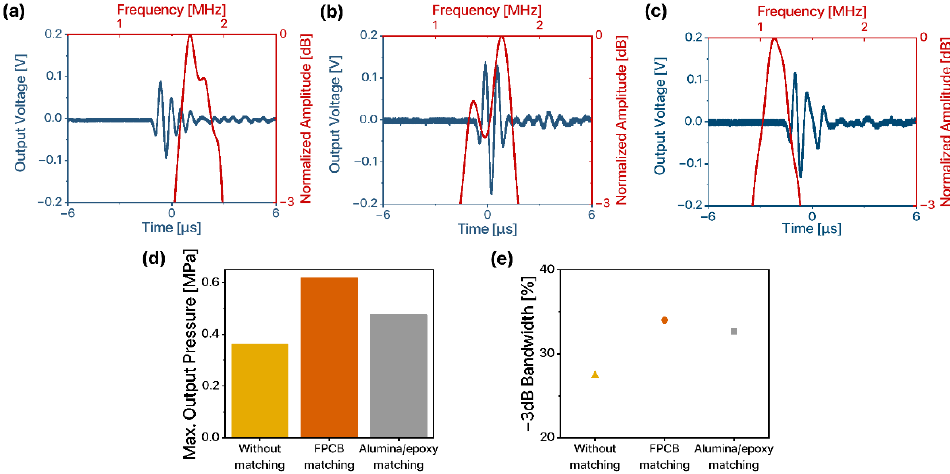
Figure 6. Acoustic characteristics of 1D linear ultrasound transducer arrays ( a ) without matching layer, ( b ) with the FPCB matching layer, and ( c ) with the alumina/epoxy matching layer. ( d ) Maxi- mum output pressure. ( e ) − 3dB bandwidth.